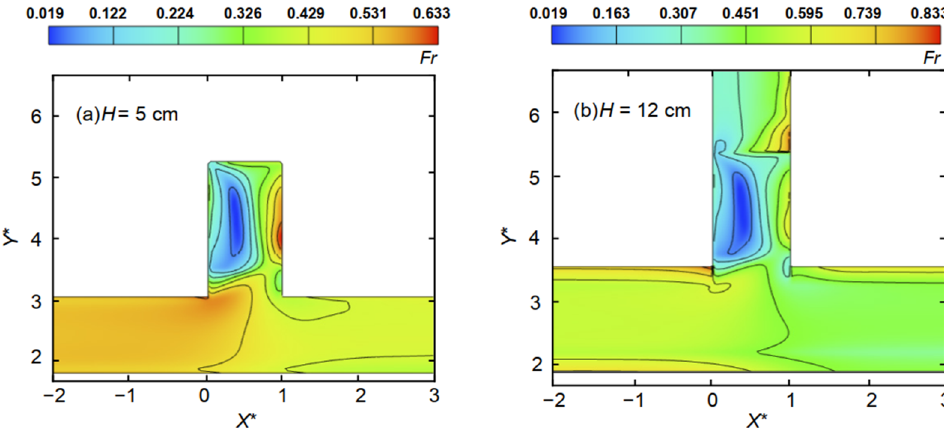
Figure 5. Froude number ( F r ) contour map at different water depths. Note: Q 1 = 40 L/s; b = 30 cm. X * and Y * are obtained by dimensionless processing of X -axis and Y -axis coordinates. ( a ) depth of water below the sill height; ( b ) depth of water above the sill height.